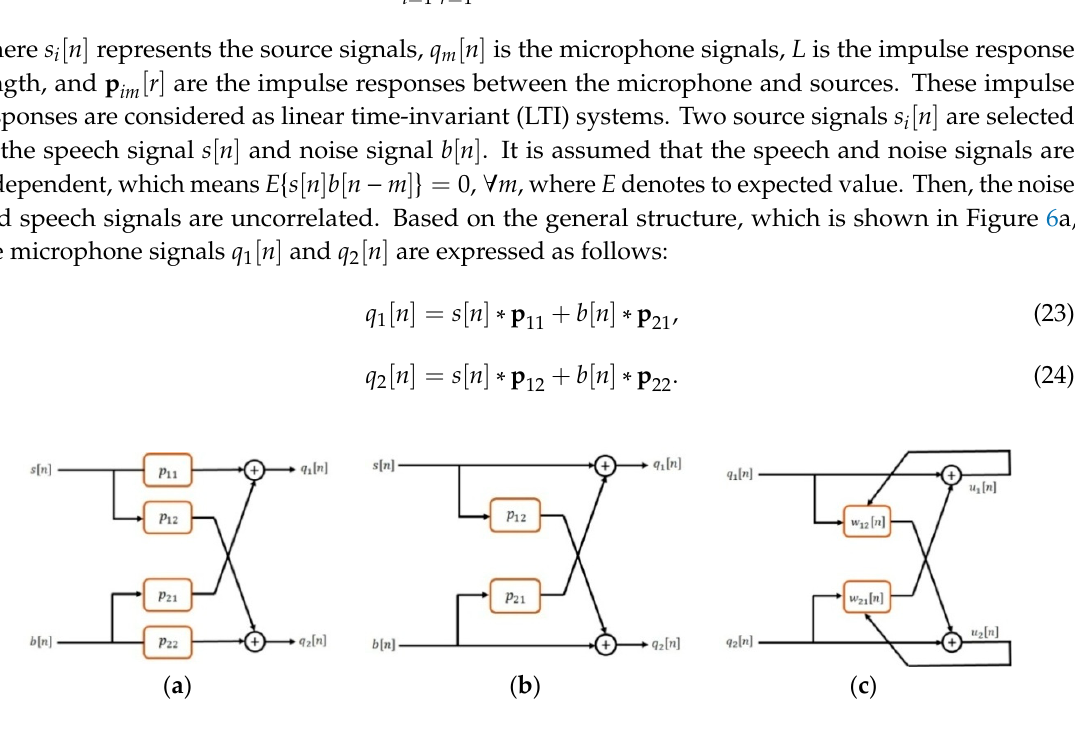
Figure 6. ( a ) The general structure of the proposed denoising system, ( b ) the simplified presented model for the two-microphone system, and( c ) the affine projection algorithm (APA) structure for the two-microphone.